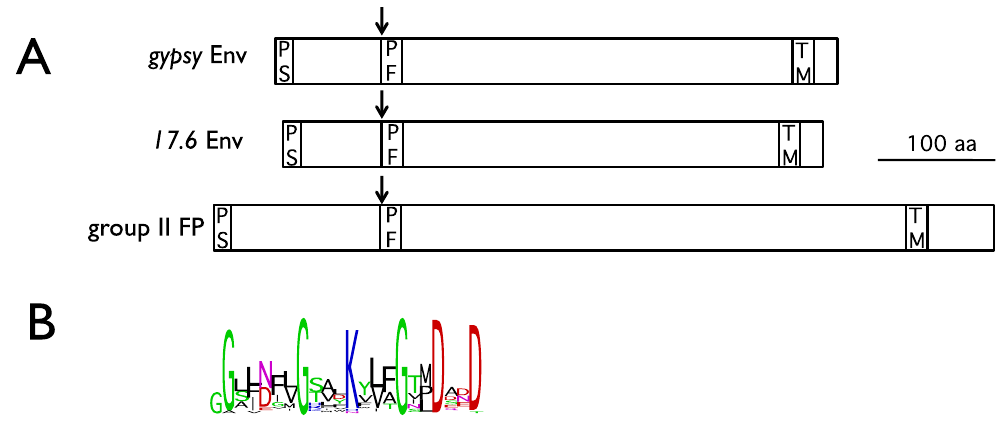
Figure 5. ( A ) comparison of gypsy Env , 17.6 Env and baculovirus group II Fusion Protein (FP) structural properties. Arrows indicate the furin cleavage site. PS, peptide signal; PF, peptide fusion; TM, transmembrane. ( B ) Logo representation (weblogo.berkeley.edu/logo.cgi) of the peptide fusion consensus sequence between 23 errantiviruses Env and 9 group II FP amino acid